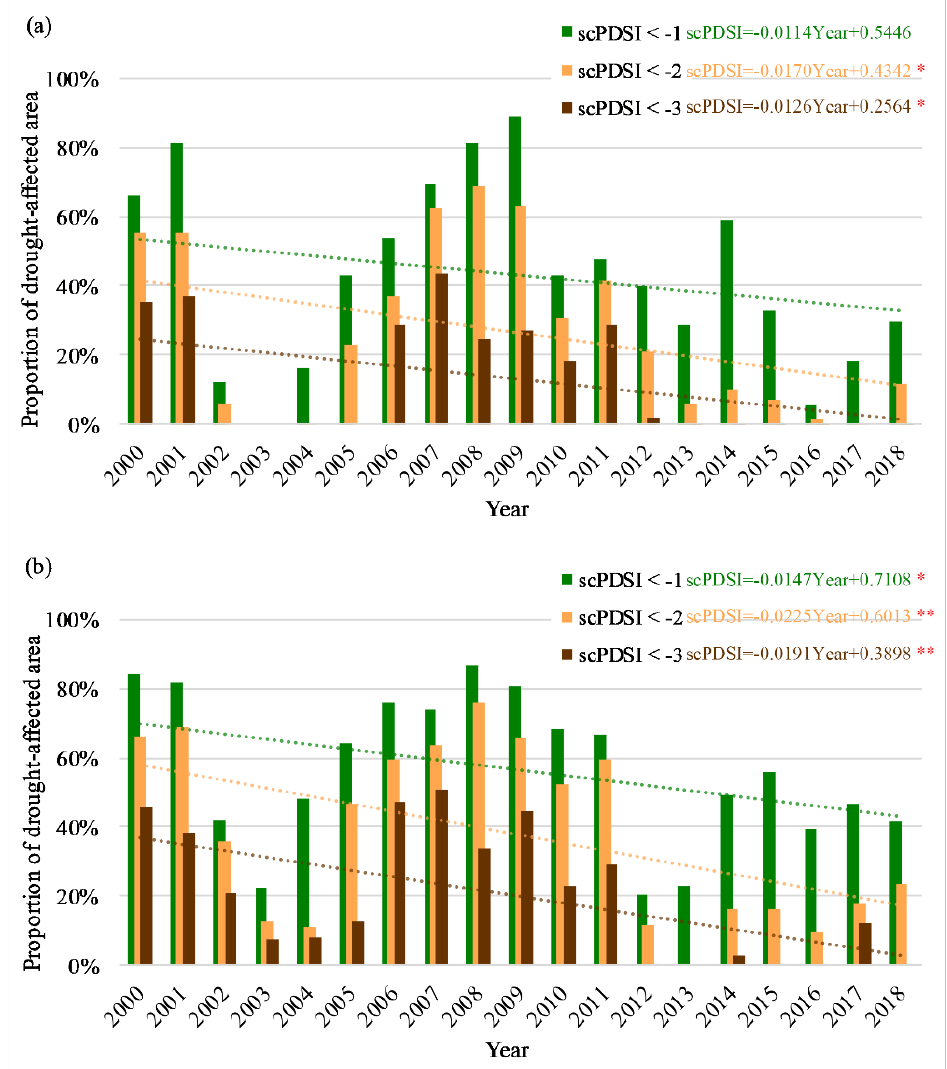
Figure 5. The proportion of drought-affected area in arid drylands ( a ) and semi-arid drylands ( b ) from 2000 to 2018. * indicates statistical significance at 0.1 level. ** indicates statistical significance at 0.05 level.